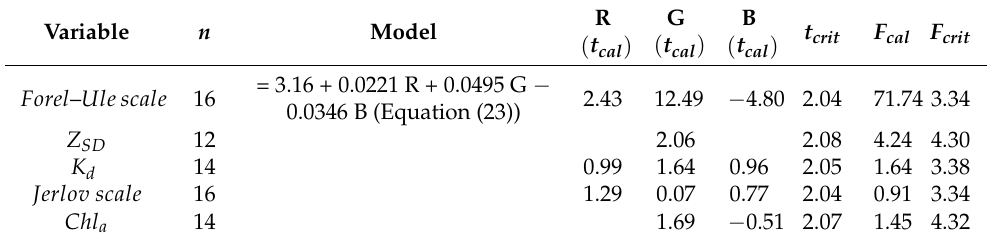
Table 5. Results of stepwise multiple regression analysis for the oceanic approach models ( α = 0.05 ) . Variable n